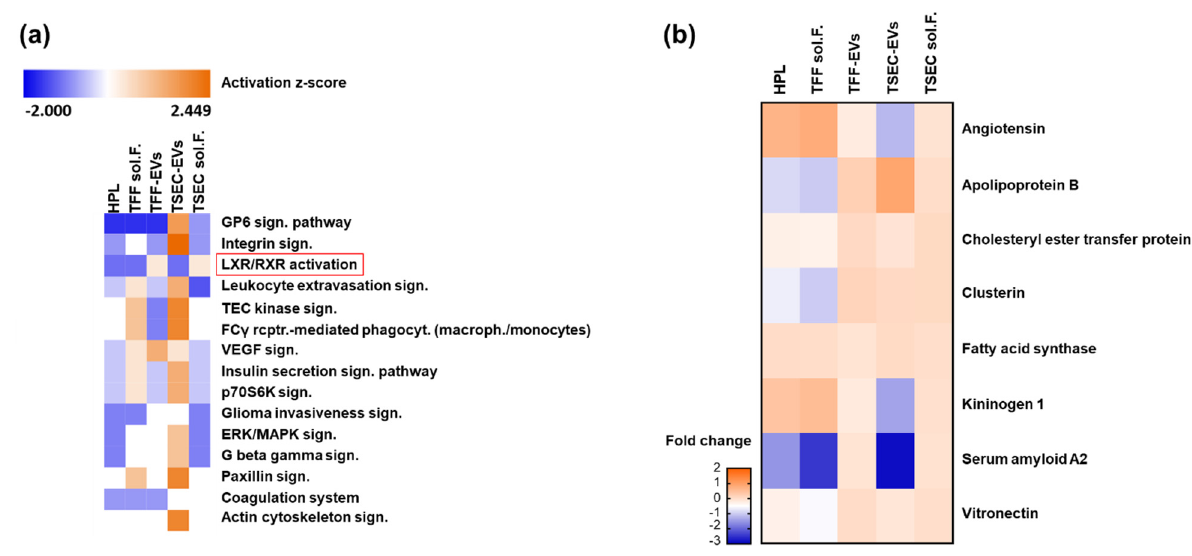
Figure A4. Proteomics pathway analysis. ( a ) Canonical Ingenuity ® pathway analysis and ( b ) protein enrichment contributing to LXR/RXR activation (red box in ( a )) in HPL, TFF-EVs, TSEC-EVs, and the corresponding TFF and TSEC soluble fractions. Table A1. Adherence to MISEV criteria for HPL-EV preparations. Used nomenclature, material col- lection and storage, EV-isolation strategy, characterization and functional studies performed are summarized.